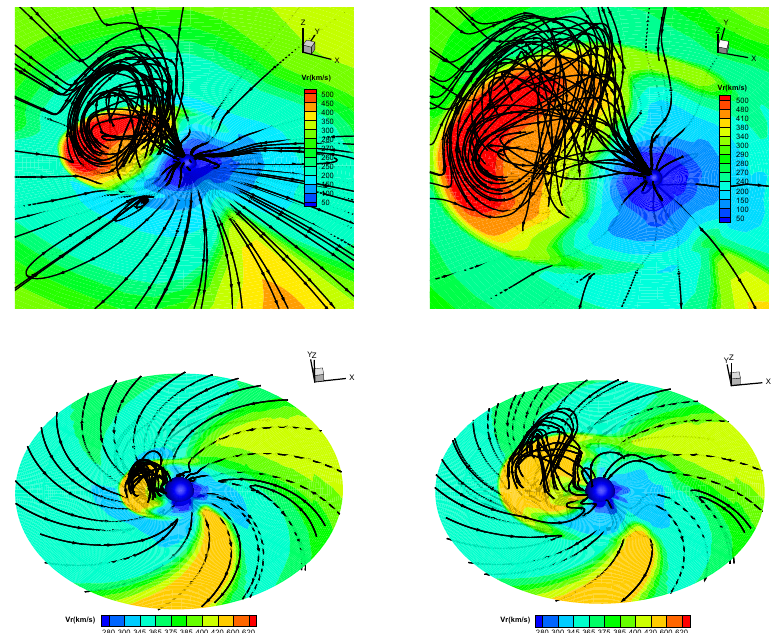
Fig. 4. A 3D representation of the CME is shown at 3 h (top left), 6 h (top right), 20 h (bottom left), and 40 h (bottom right). The color code represents the velocity magnitude in the x – y equatorial plane. The streamlines showed in black denote the magnetic fi eld lines. The blue sphere in the fi rst row is the Sun, and in the bottom row represent 20 R s .